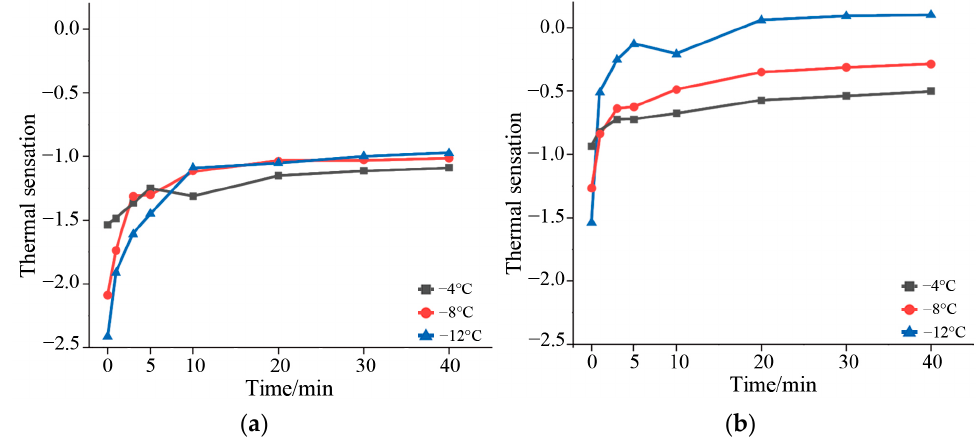
Figure 6. Thermal sensation. ( a ) Low activity; ( b ) high activity.